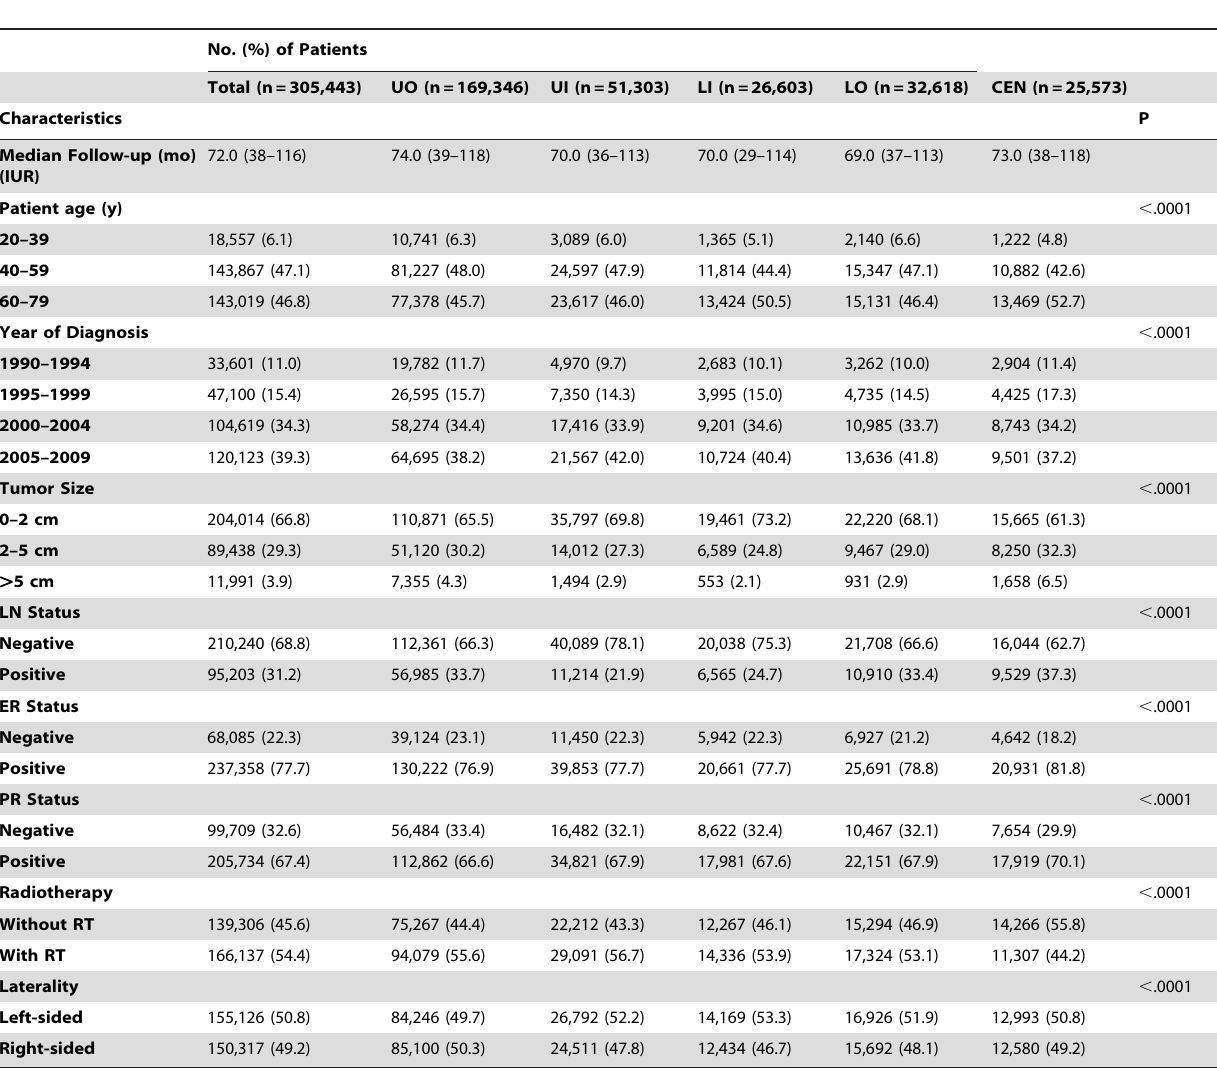
Table 1. Clinicopathologic Characteristics of Breast Cancer Patients from SEER Database by Primary Site.